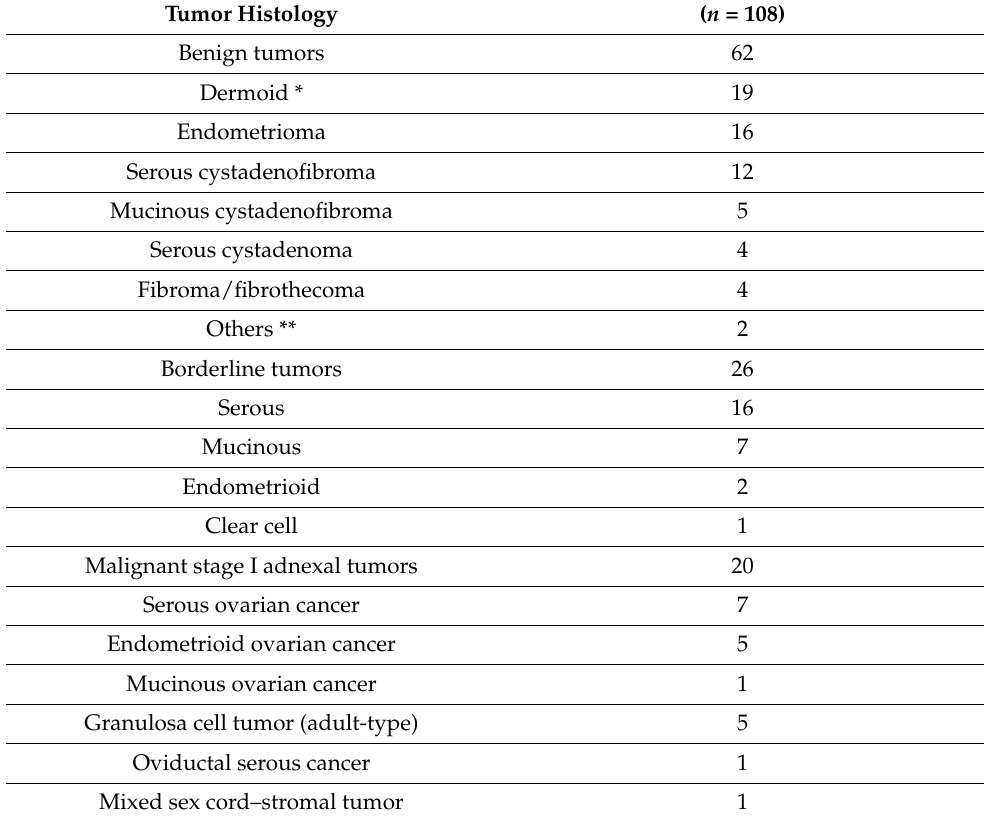
Table 1. Histological diagnosis of adnexal tumors in the studied group. Tumor Histology ( n =